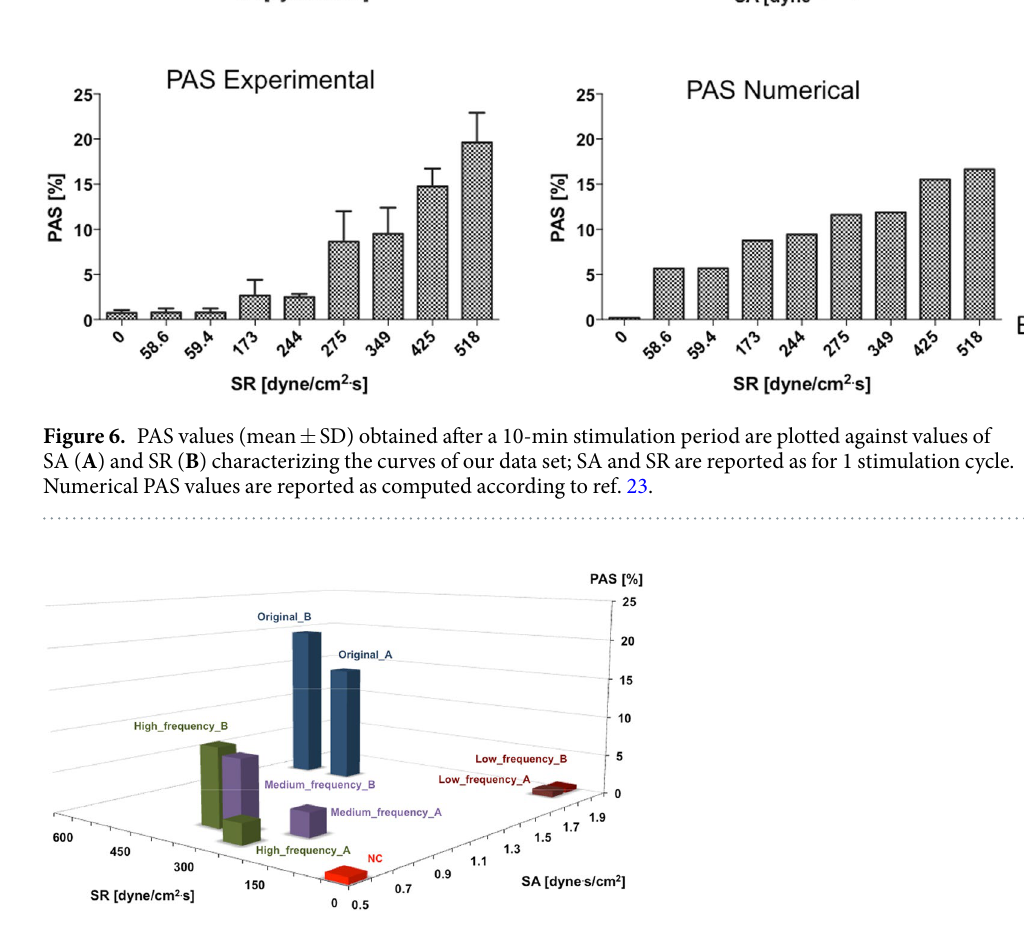
Figure 7. Experimental values of PASt 10 are plotted in the SR-SA plane, allowing to comprehensively evaluate the effect of simultaneous variations of SA and SR in terms of induced PA: higher PAS values correspond to curves characterized by high values of both SA and SR; high values of SA alone do not induce any significant increase of PAS; increasing values of SR allows to significantly activate platelets. SA and SR are reported as for 1 stimulation